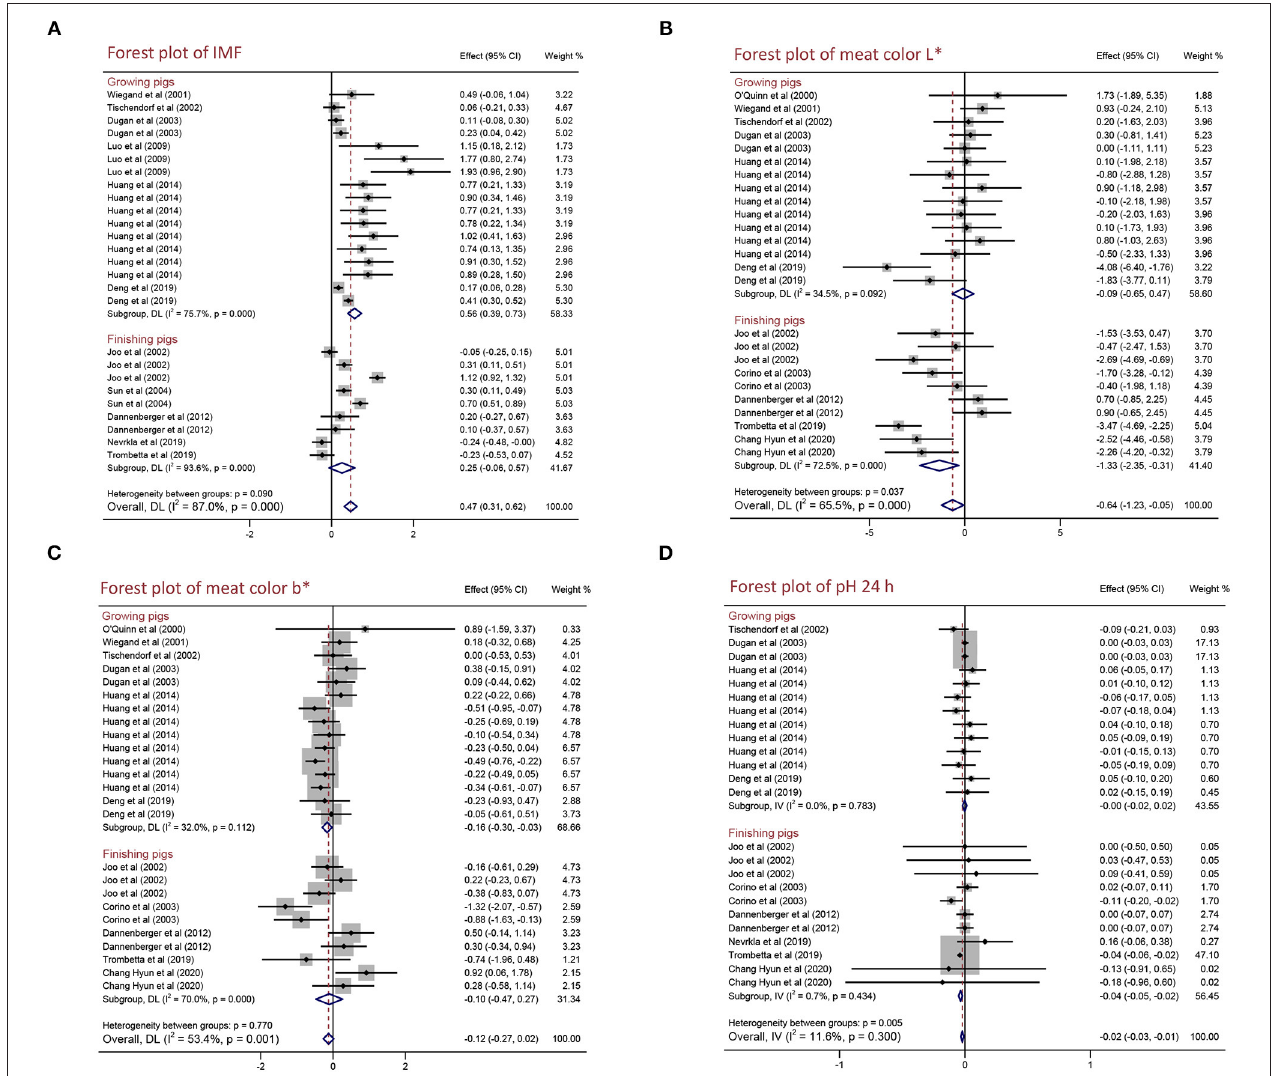
FIGURE 4 | Forest plot of the effects of polyunsaturated fatty acid (PUFA) supplementation on the meat quality of growing and finishing pigs. (A) IMF, (B) meat color L*, (C) meat color b*, and (D) pH 24h. WMD, weighted mean difference; CLA, conjugated linoleic acid. The small solid diamond represents the point estimate for each individual trial, and the horizontal line extending from each solid diamond represents the upper and lower limits of the 95% CI. The size of the shaded square indicates the relative weight of the trial in the meta-analysis. The hollow diamond represents the WMD and 95% CI of the trials, no intersection of the diamond and the solid black line in the middle indicates a significant difference ( p < 0.05), vice